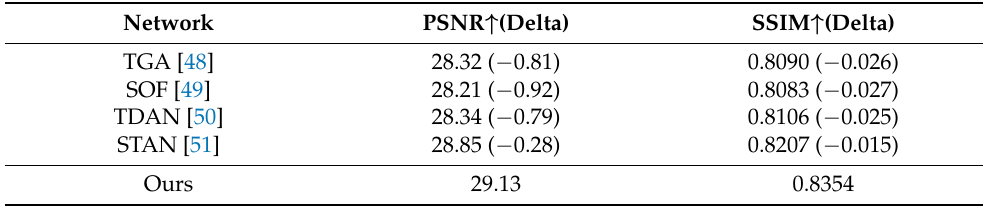
Table 7. Average PSNR (dB) and SSIM on the REDS4 test datasets.